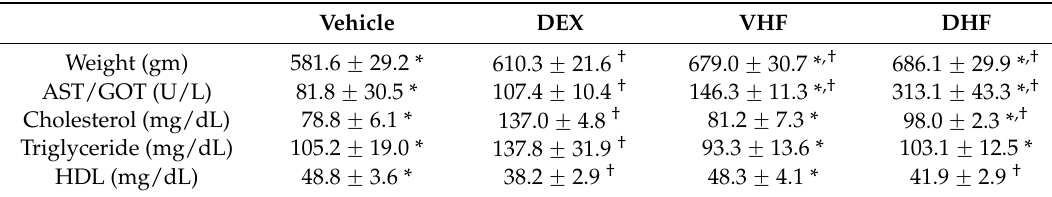
Table 1. Demographic features and biochemical data of the studied